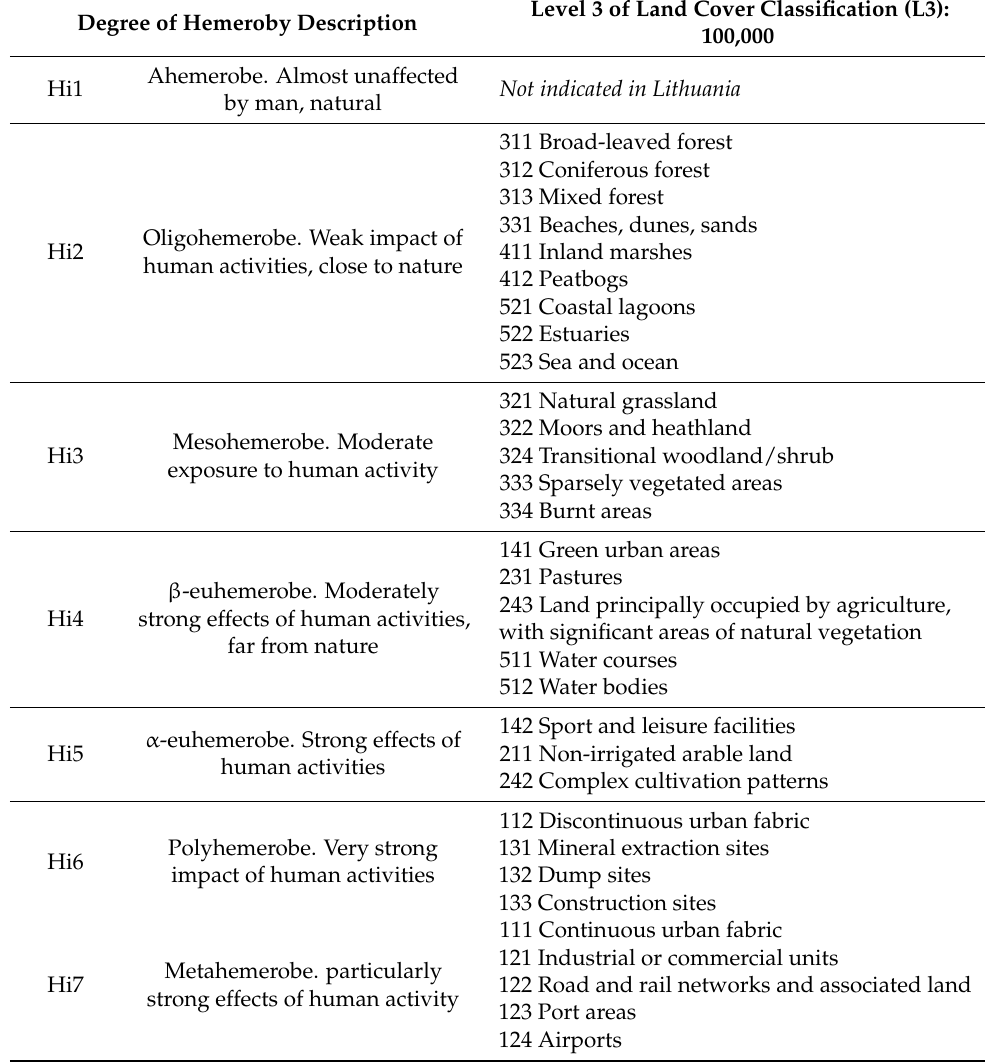
Table 1. Naturalness and hemeroby indices of land-cover types in Lithuania according CORINE data. The degree of naturalness (hemeroby index) adopted from